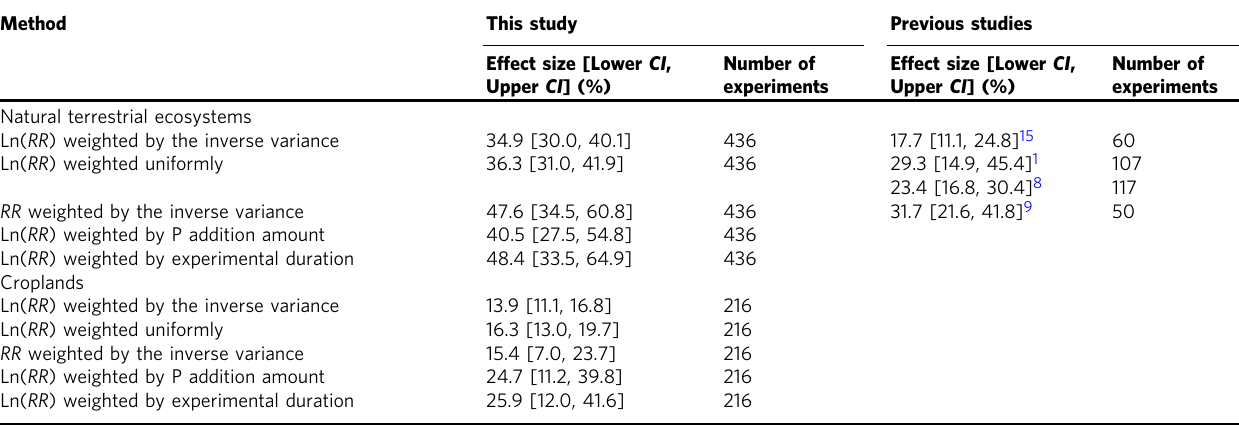
Table 1 The magnitude of P limitation in natural terrestrial ecosystems is larger than previously